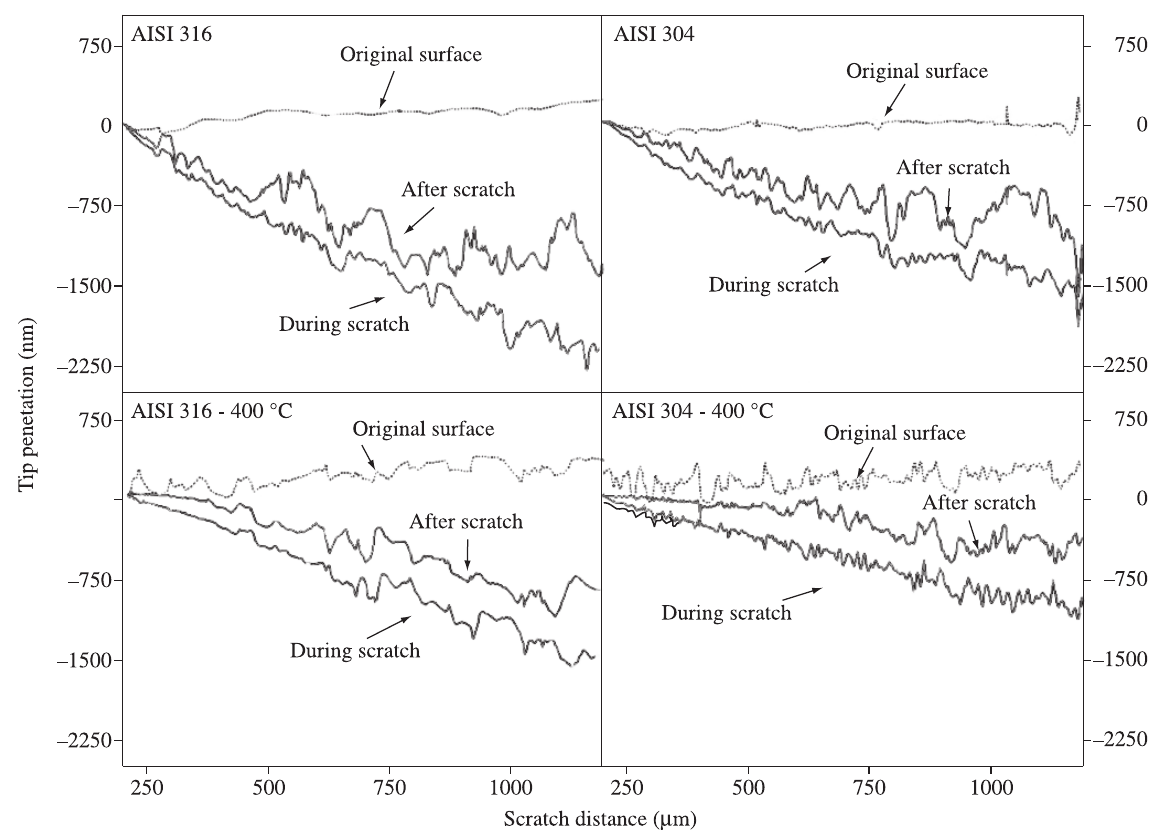
Figure 8. Typical tip penetration profiles produced by nanoscratch tests for AISI 304 and AISI 316 samples: untreated, and nitrided at 500 °C. Note the dif- ferent depth